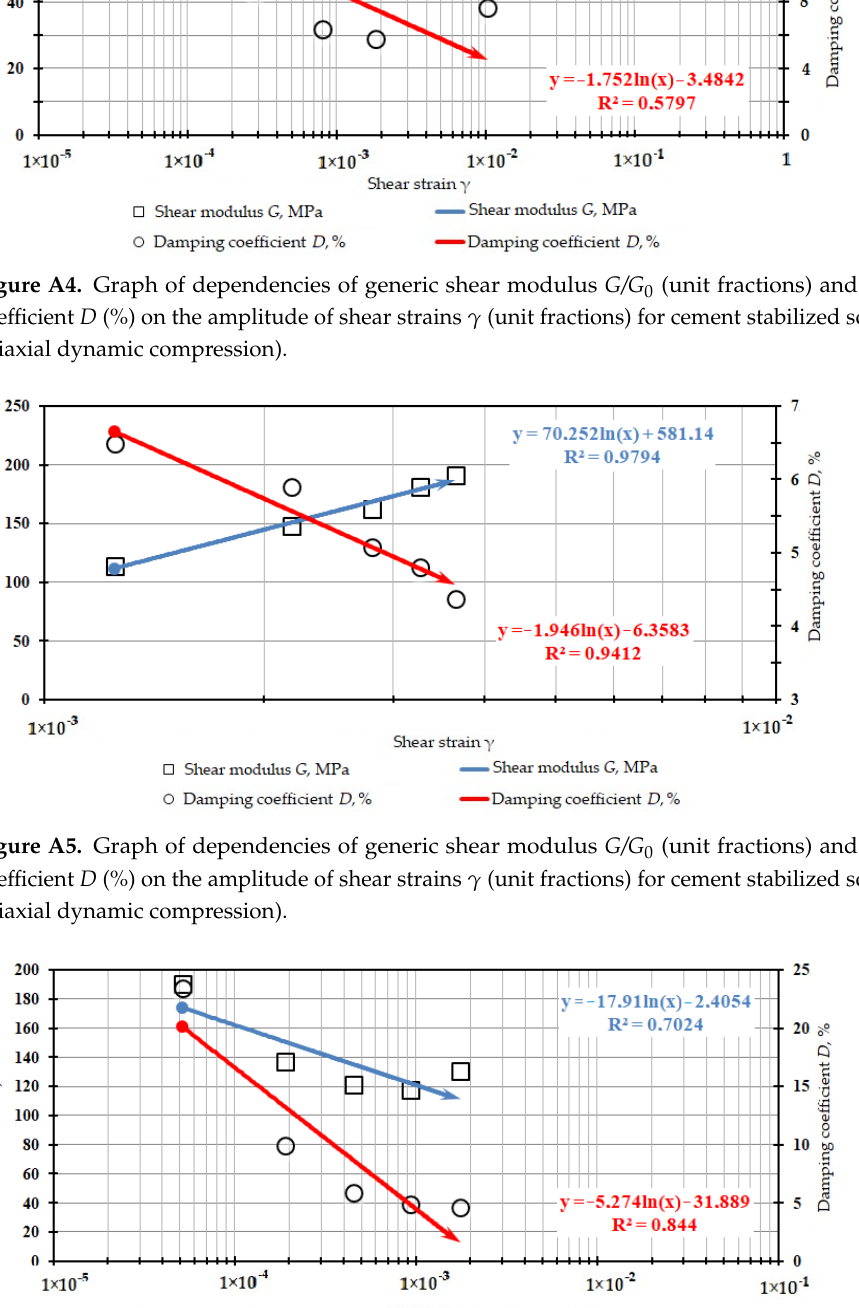
Figure A6. Graph of dependencies of generic shear modulus G/G 0 (unit fractions) and damping coefficient D (%) on the amplitude of shear strains γ (unit fractions) for cement stabilized soils. Test 6 (triaxial dynamic compression).